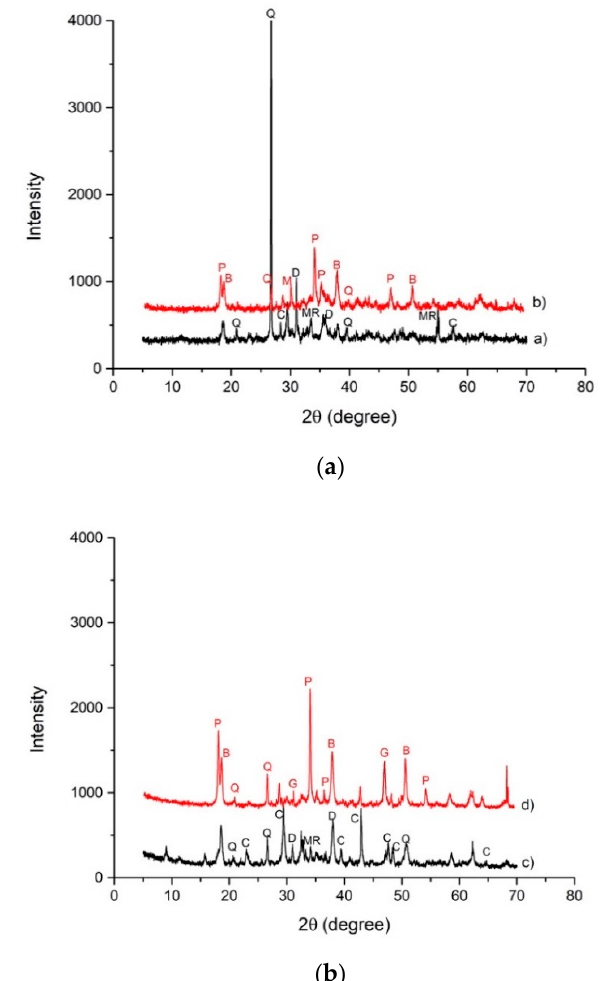
Figure 4. ( a ) XRD patterns collected on Slag A a) and Slag A after NaOH 8M test b) (C = calcite, P = portlandite, Q = quartz, D = dolomite, MR = merwinite, B = brucite). ( b ) XRD patterns collected on Slag R c) and Slag R after NaOH 8M test d) (C = calcite, P = portlandite, Q = quartz, MR = merwinite, B = brucite, G = gehlenite).